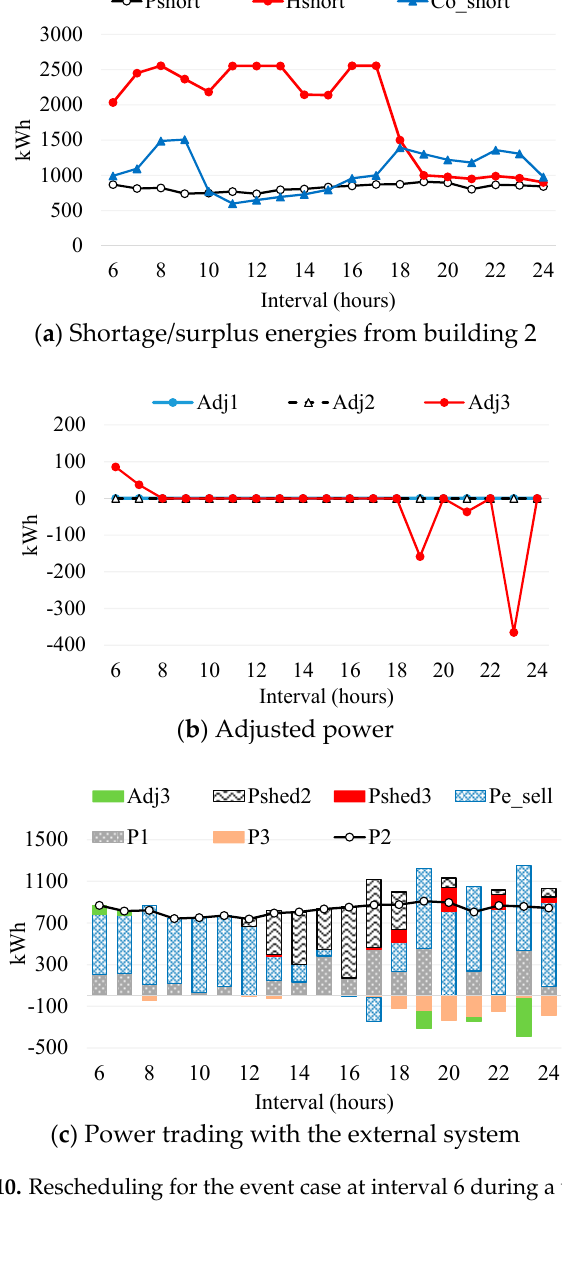
Figure 10. Rescheduling for the event case at interval 6 during a weekday.